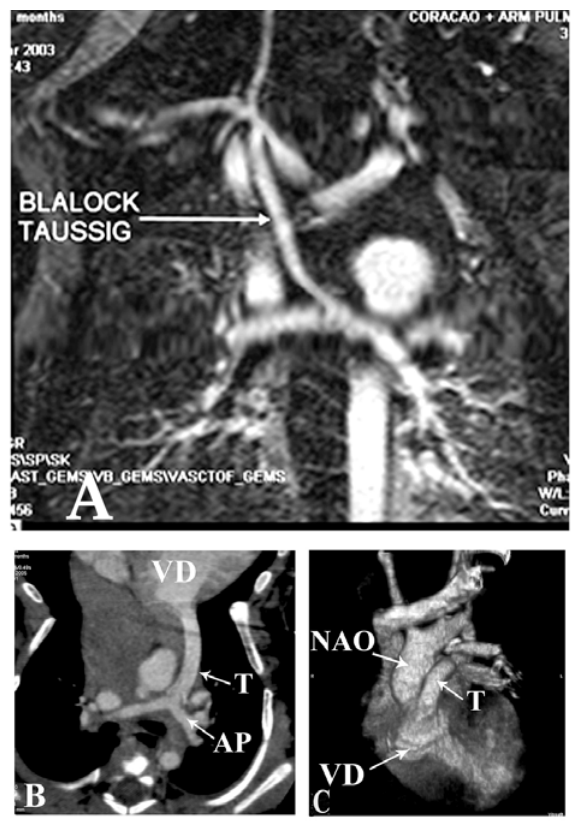
Fig. 1 - Fontes de perfusão pulmonar: - A: Angioressonância magnética (reconstrução multiplanar) mostrando